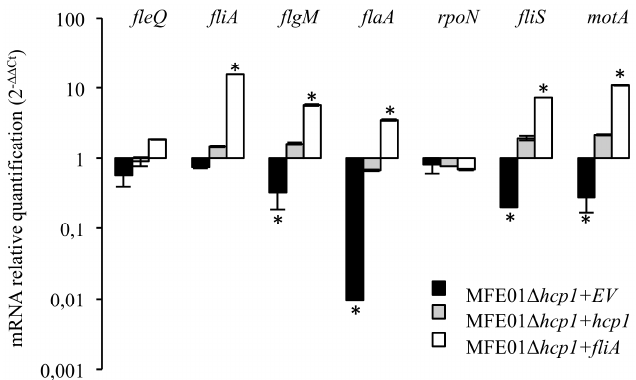
Figure 6. Expression of flagellar genes in various MFE01 mutants. The mRNA levels shown are relative to those obtained in MFE01 carrying the empty pPSV35 vector. Relative levels of gene expression are based on the comparative CT (2 – ΔΔ CT ) method, using MFE01 recA mRNA as endogenous control. Statistical analyses were performed using Non-parametric Mann–Whitney Tests (two tailed). A p -value < 0.05 was considered to be statistically significant. * p < 0.05, n = 6. Data shown represent the mean ±